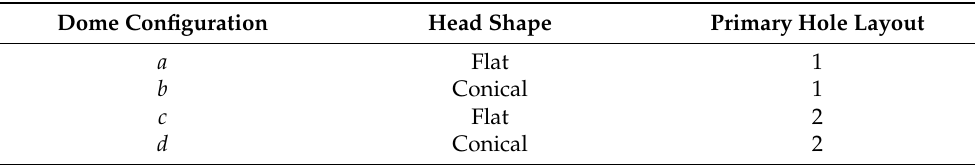
Table 5. Different dome configuration